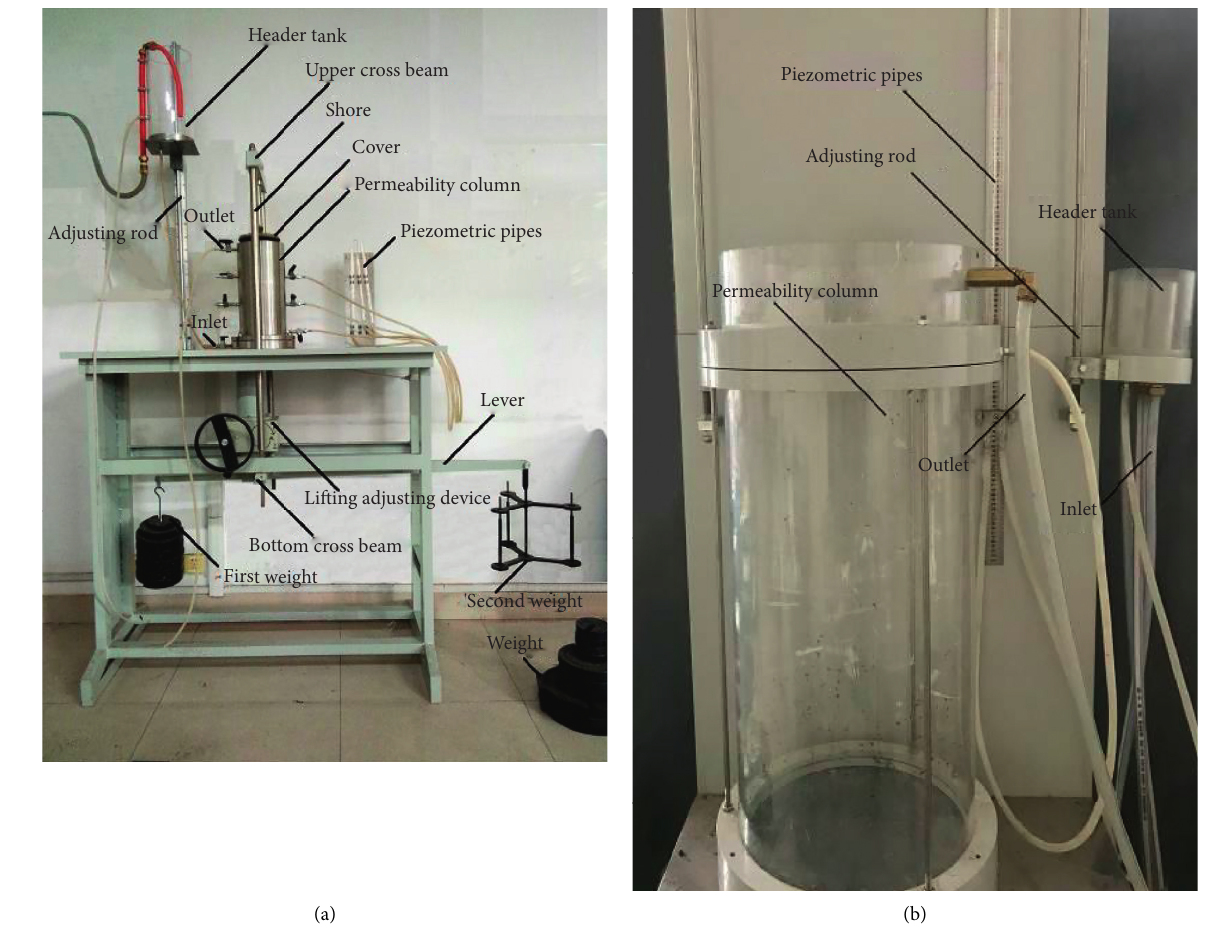
Figure 3: Permeability apparatus. (a) Compression and permeability combined apparatus. (b) Large-scale vertical permeability